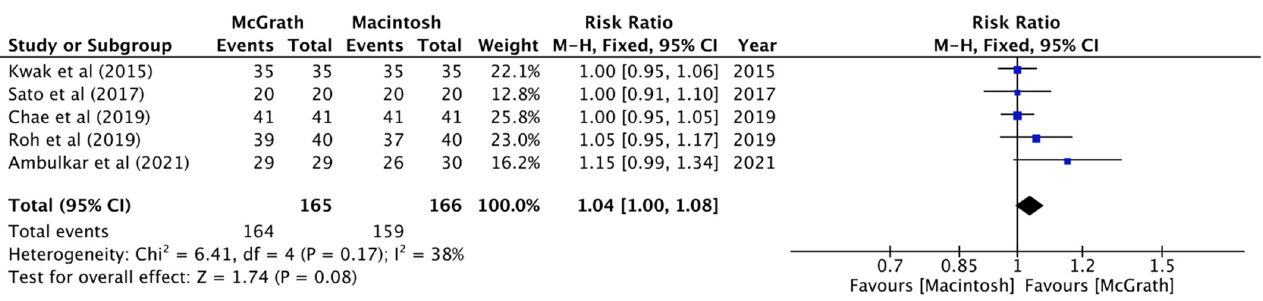
Figure 4. Forest plot of the first-attempt success rate (McGrath vs. Macintosh laryngoscope).